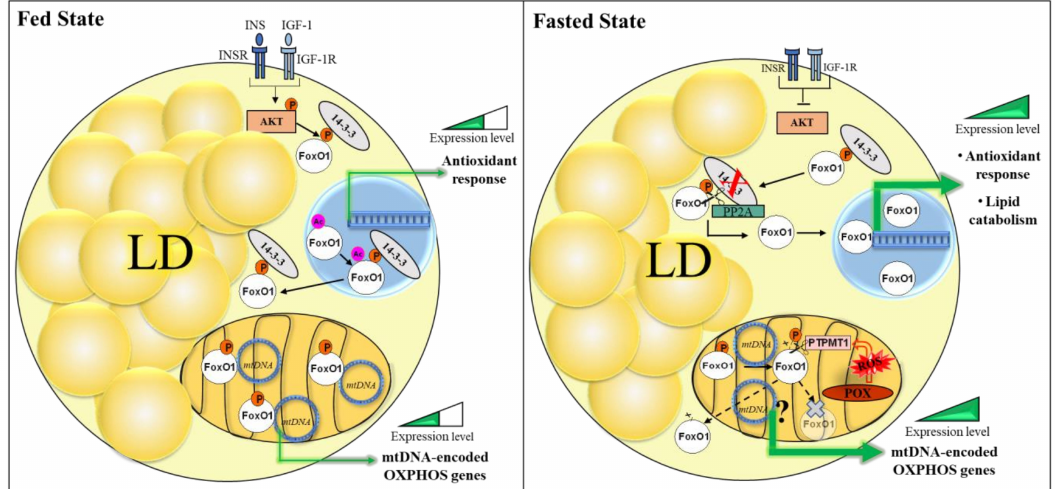
Figure 3. Subcellular distribution of FoxO1 driven by nutritive stimuli in white / beige adipocytes. Upon fed state, phosphorylated FoxO1 (p-FoxO1) localizes in the nucleus, cytoplasm, and mitochondria. The insulin signal activates the AKT pathway phosphorylating FoxO1. The phosphate group is an anchor for binding to 14–3–3 proteins in the cytoplasm. In the nucleus, p-FoxO1 is inactive, binds 14–3–3, and shuttles to the cytoplasm. In mitochondria, FoxO1 binds mtDNA mitigating the mtDNA-encoded gene expression. Upon fasted state, FoxO1 is dephosphorylated by PP2A in the cytoplasm, migrating to the nucleus to induce lipid catabolism (ATGL, LIPA) and antistress response genes (SOD2, UCP1). The fasted state induces proline oxidase / dehydrogenase (POX / PRODH) that produces mitochondrial ROS that activates PTPMT1. The dephosphorylation permits mitochondrial FoxO1 exclusion and increased mtDNA-encoded genes expression. Then, FoxO1 could be degraded or recruited to the cytoplasm /